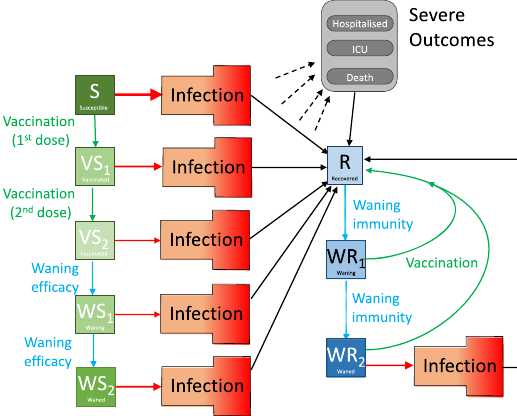
Fig. 3 | Graphical schematic of the models used in the paper. The left-hand schematicshowstheprogressbetweendifferentcompartments.Infectionisshown as a red arrow (with the size providing some indication of the risk), recovering is shown by black arrows, the two-dose vaccination is shown in green, while waning protection is in light blue. The infection compartment is multi-dimensional and shownintheright-handschematic.Itcapturesinfection,themultiplelatentclasses